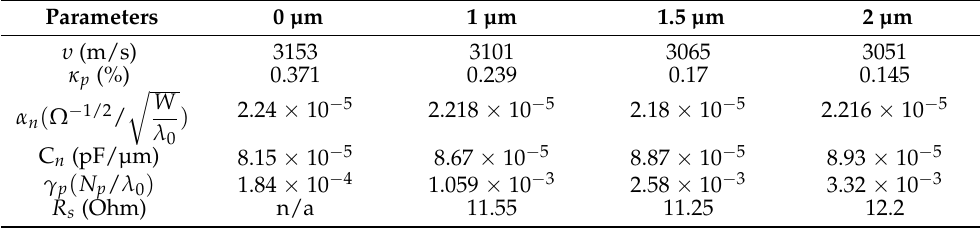
Table 4. COM parameters for split aluminum electrodes on AT-cut quartz substrate for different parylene C coating thicknesses ( h / λ 0 =